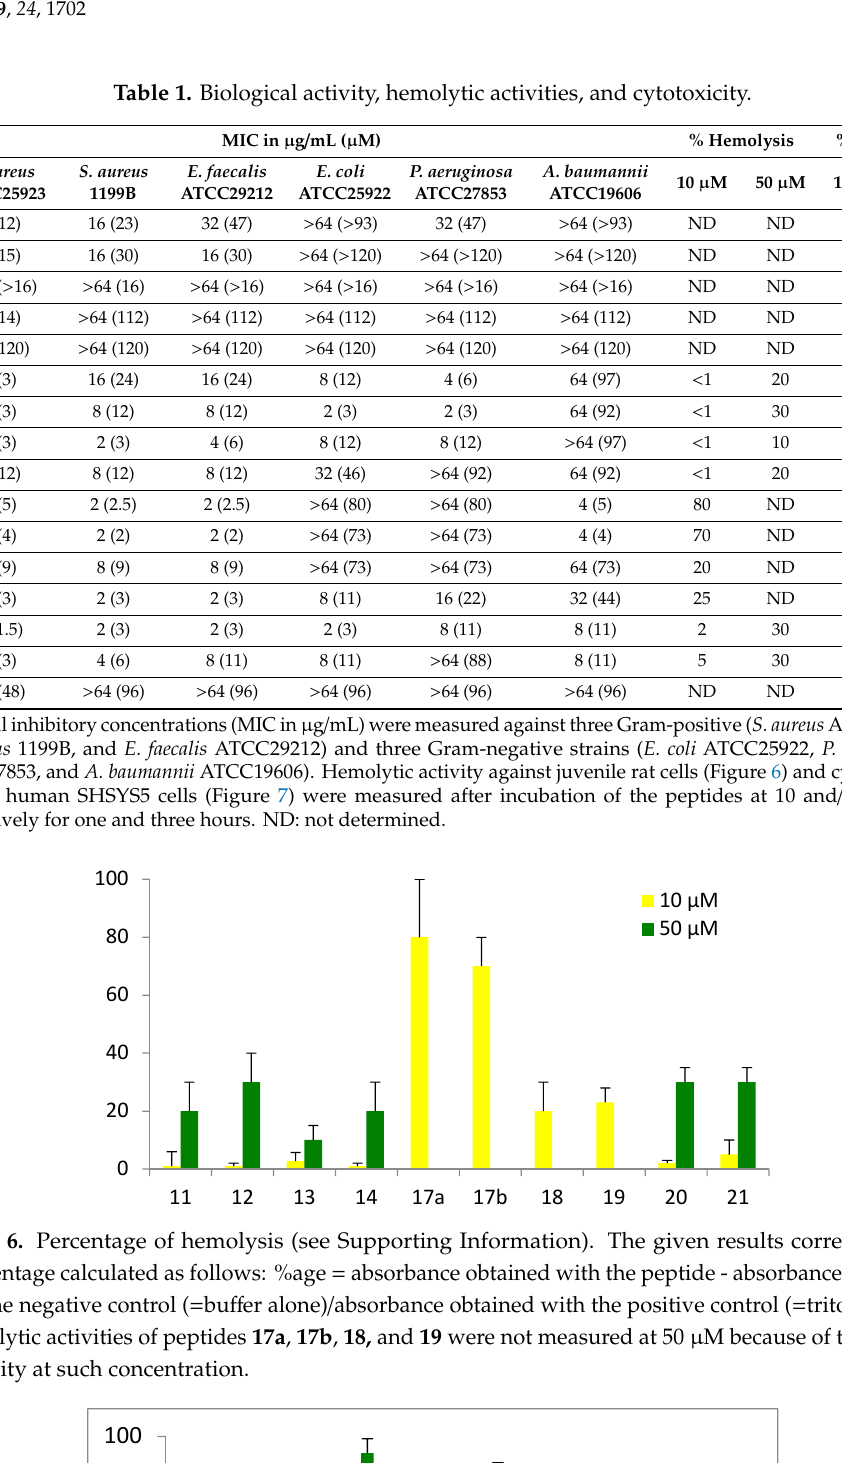
Cytotoxicity on Human SH-SYS5 Cells